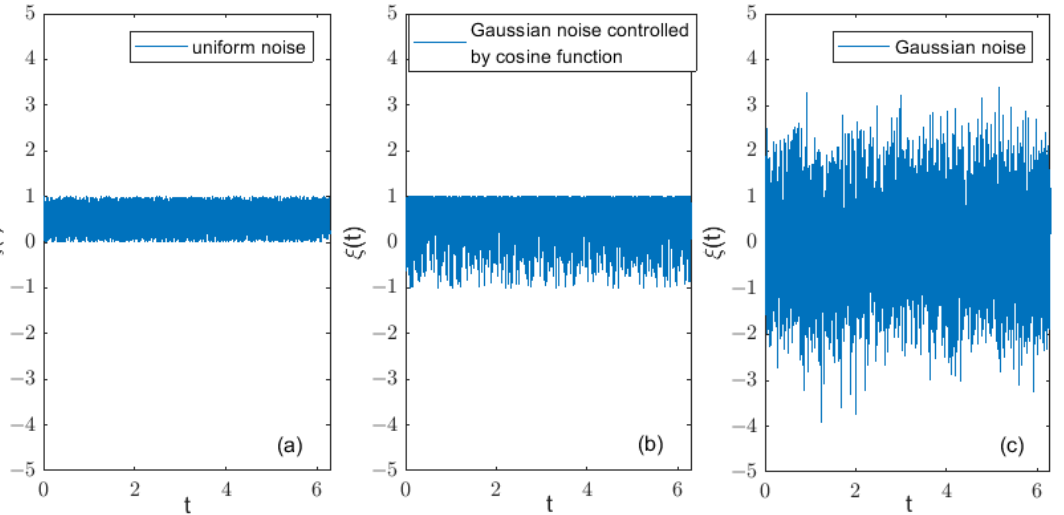
Figure 10. Uniform noise ( a ), Gaussian noise controlled by cosine function ( b ) and Gaussian noise ( c ) with intensity of 1.